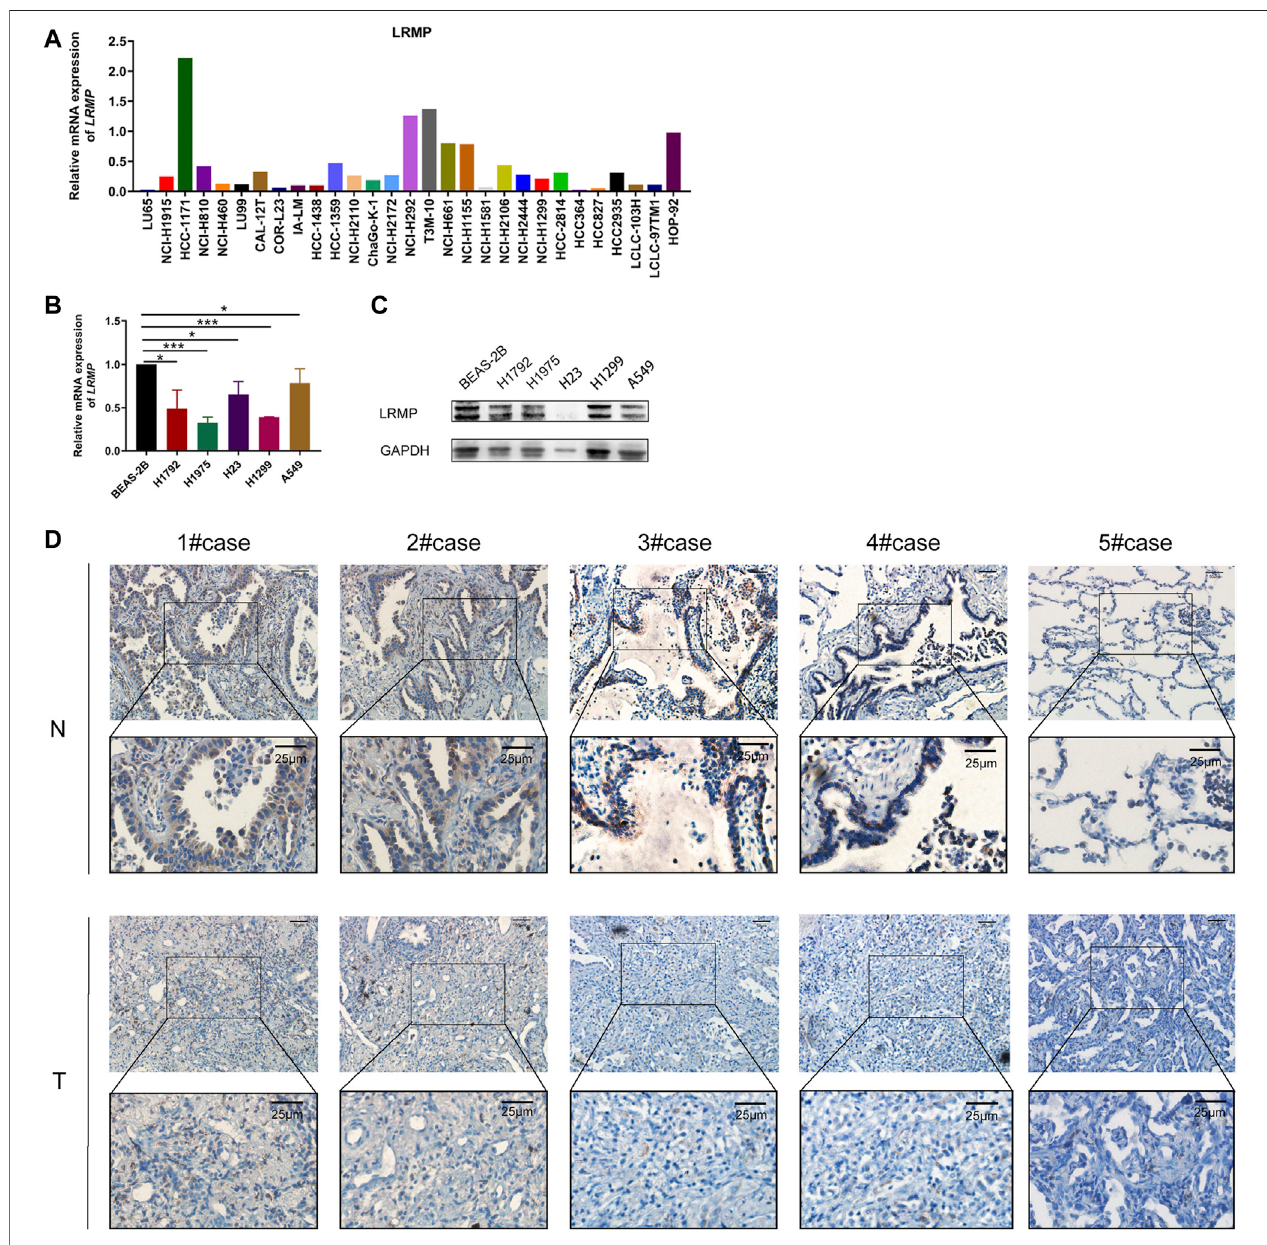
FIGURE 2 | The expression level of lymphoid-restricted membrane protein (LRMP) in cell lines and LUAD tissue. (A) LRMP mRNA level in different cell lines accordingtoCCLE. (B – C) mRNAandproteinexpressionofLRMPinLUADcelllines. (D) RepresentativeIHC fi guresofLUADtissuesandpairednormaltissuestainedfor LRMP